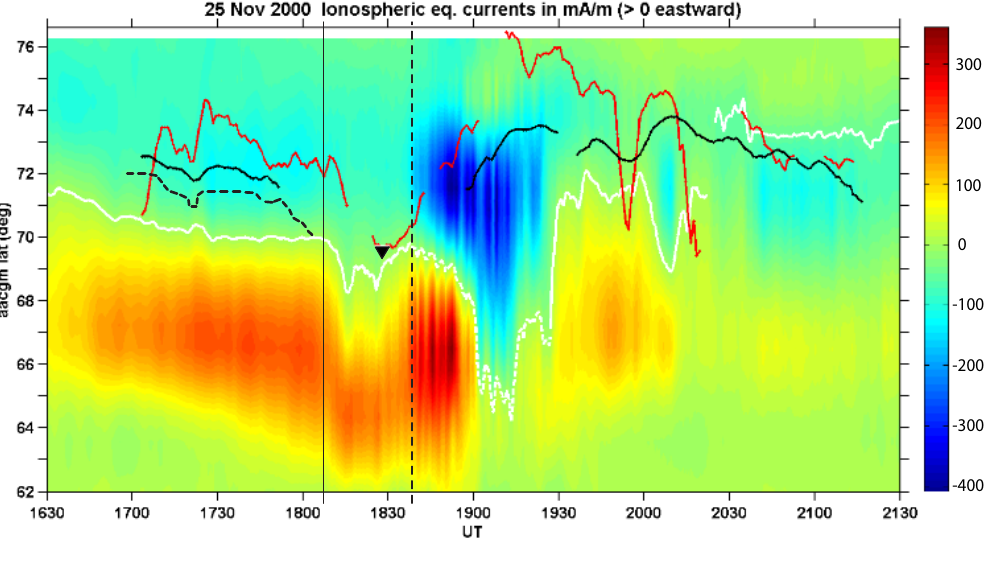
Fig. 8. Equivalent east-west currents calculated from the MIRACLE magnetometer data. Red colour indicates eastward and blue westward flowing electrojet in mA/m (scale on the right). The white line represents the magnetic convection reversal boundary and the Harang discontinuity period is shown by a dashed line. The solid black curve is the PCB by the EISCAT VHF and the red curve is the 5-min running mean of the UVI PAE boundary. The substorm onset at 18:07UT is marked by a vertical solid line and the expansion to the EISCAT and MIRACLE MLT at 1838 UT by a dashed line. The black triangle at 18:28UT is the DMSP F15 particle PCB (b5e) measured in the EISCAT MLT